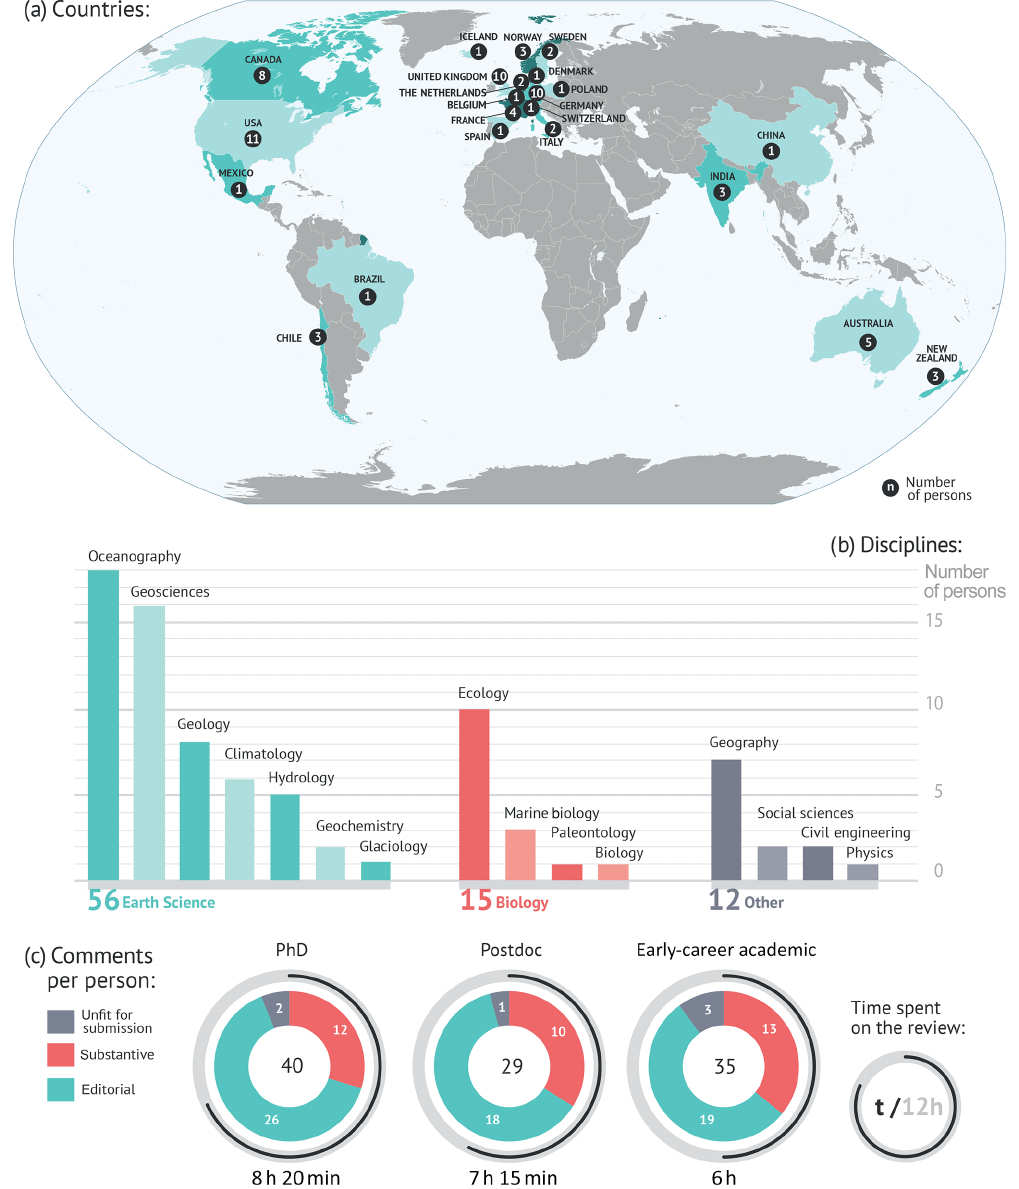
Figure 1. Summary of the results from the APECS group review: (a) geographical distribution of ECSs who participated in the process and the number of participants per country, (b) disciplines of the participants involved in the group review, and (c) comments and time spent per participant by academic stage (the average training time was 3.5h per participant, regardless of career